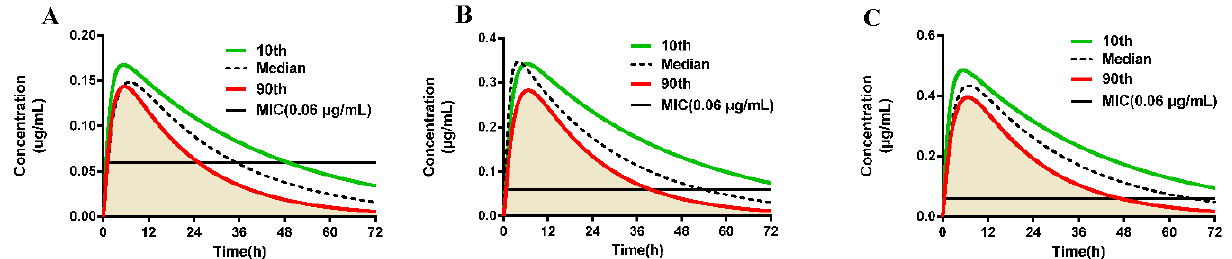
Figure 4. Monte Carlo analysis of free DCF concentrations in plasma for different doses using the population PBPK model. ( A ) represents 0.22 mg/kg; ( B ) represents 0.46 mg/kg; ( C ) represents 0.64 mg/kg.